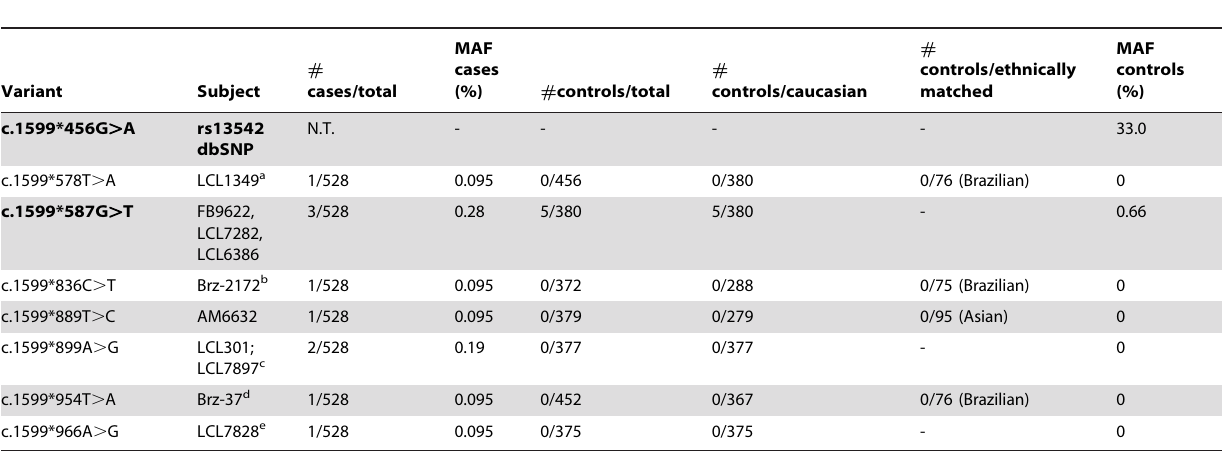
Table 1. ZIC2 enhancer mutational screening and control results by TaqMan Assay.